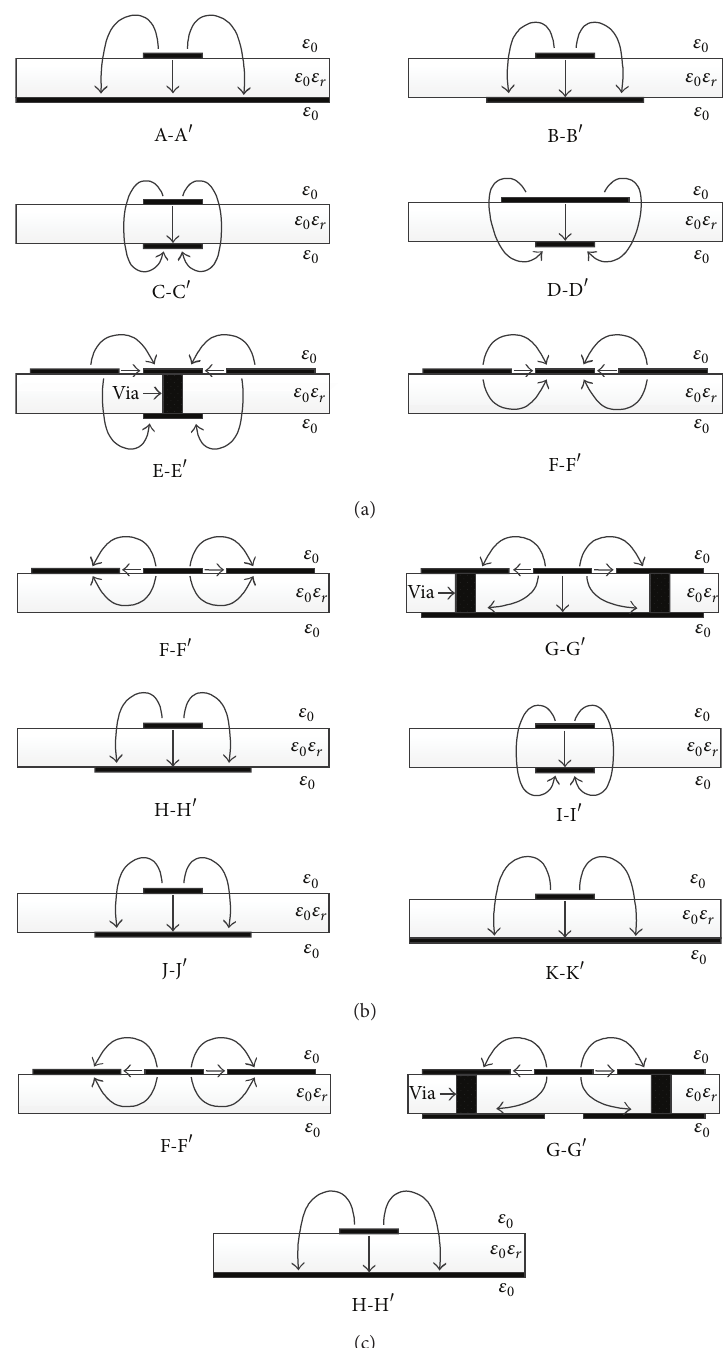
Figure 3: Electric field line distributions of the transition: (a) MSL-PSL-CPW (Types A and B), (b) CPW-PSL-MSL (Type A), and (c) CPW- MSL (Type